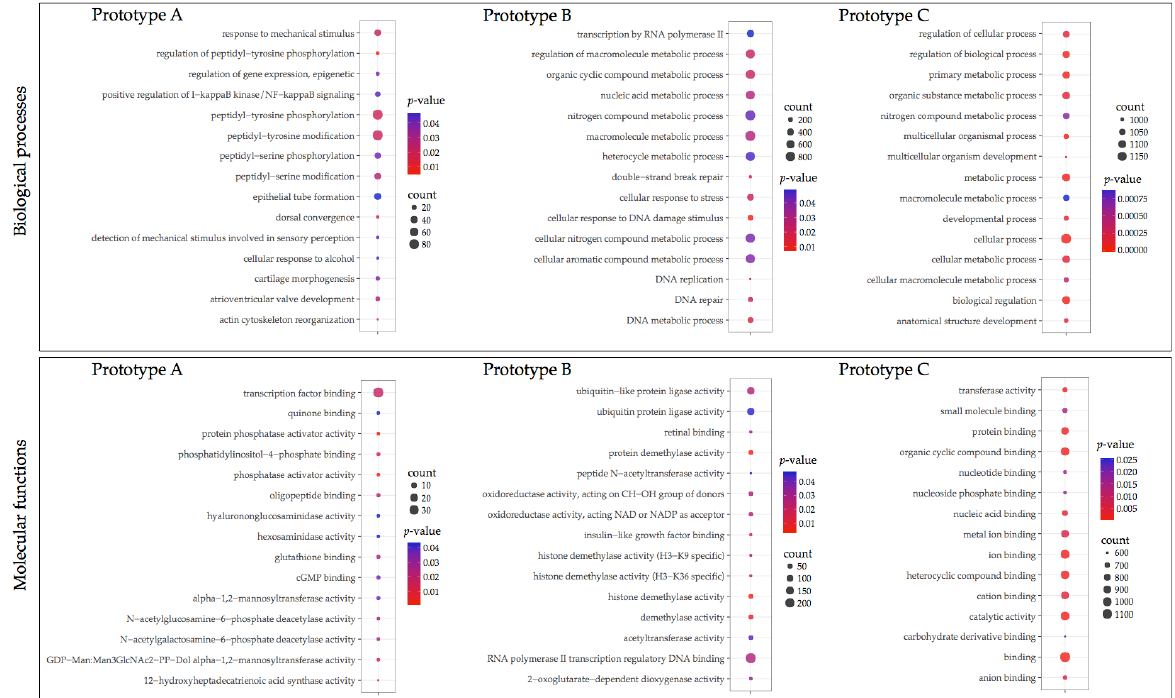
Figure 4. Gene ontology enrichment of differentially expressed transcripts in the head kidney of vaccinated fish groups. The size of the circles indicates the number of transcripts that enriched the GO term. Colors indicate the p -value.